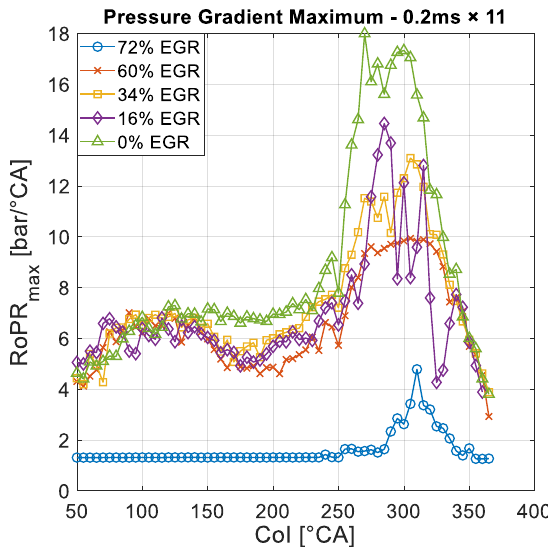
Figure 17. The pressure gradient maxima of the 0.2 ms × 11 structure with different EGR rates in the function of CoI.